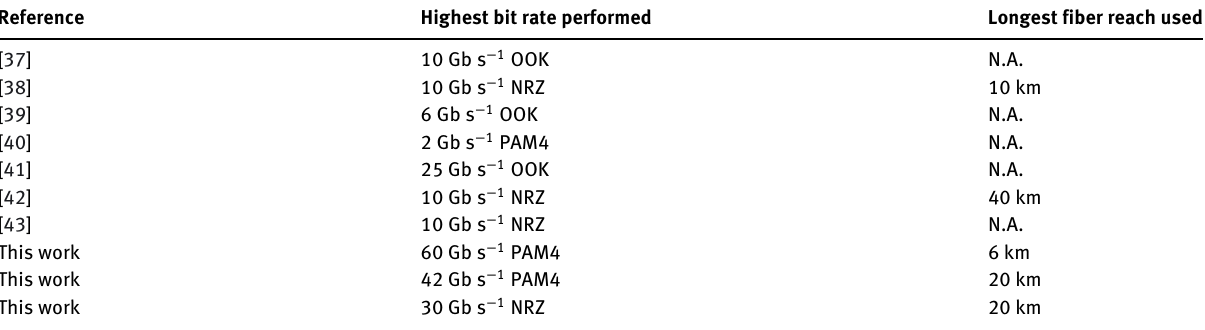
Table 2: Comparison of our work against the state-of-the-art for IMDD-compatible, microresonator-based high-speed data transmission.